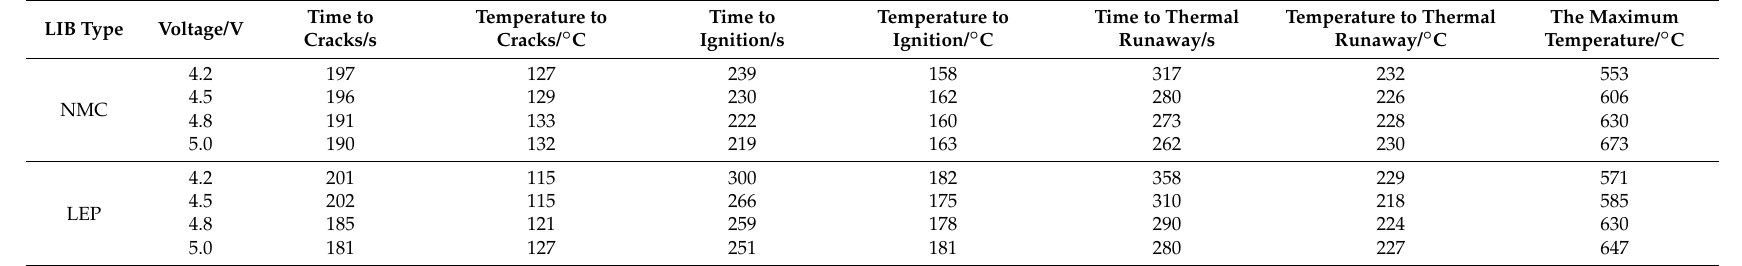
Table 2. Specifications of the battery surface